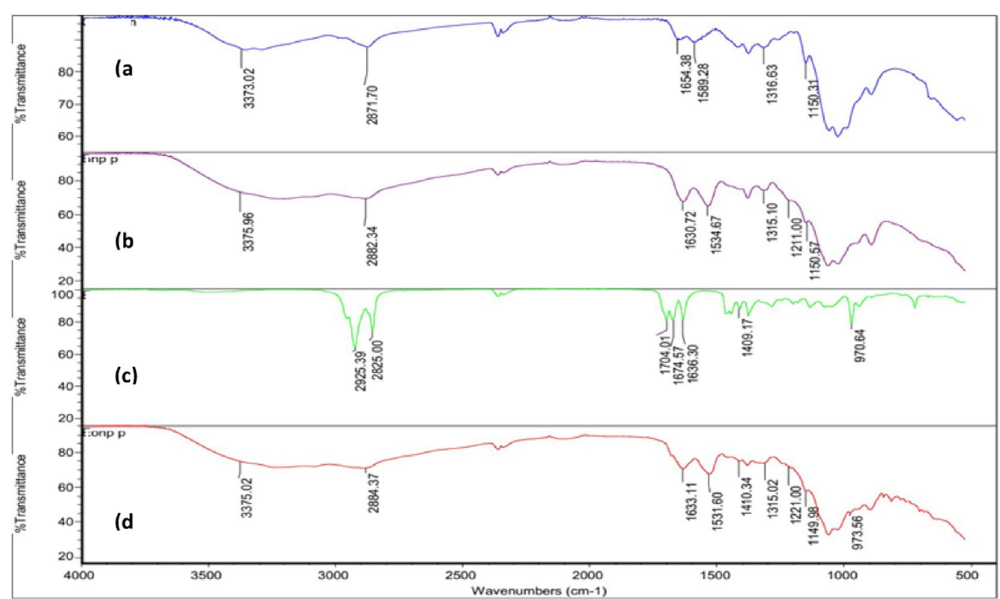
Figure 3. FTIR spectra of ( a ) pure chitosan, ( b ) chitosan nanoparticles, ( c ) H. pineodora essential oil and d) H. pineodora essential oil